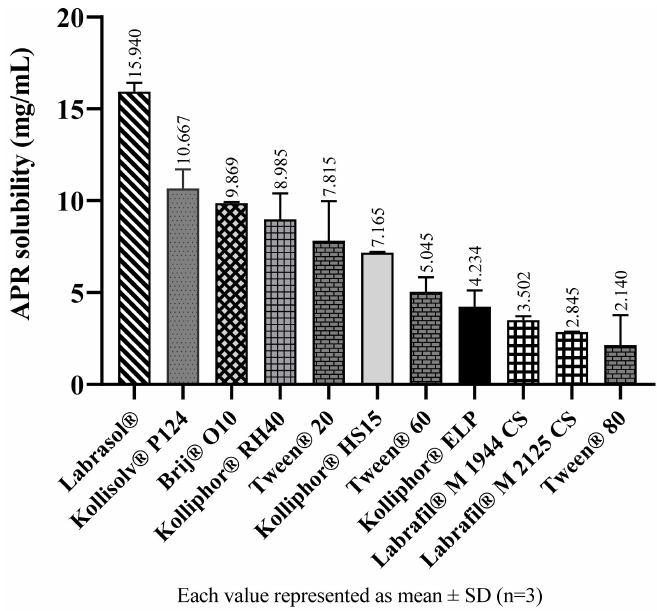
Figure 4. The solubility of APR at 25 ◦ C in